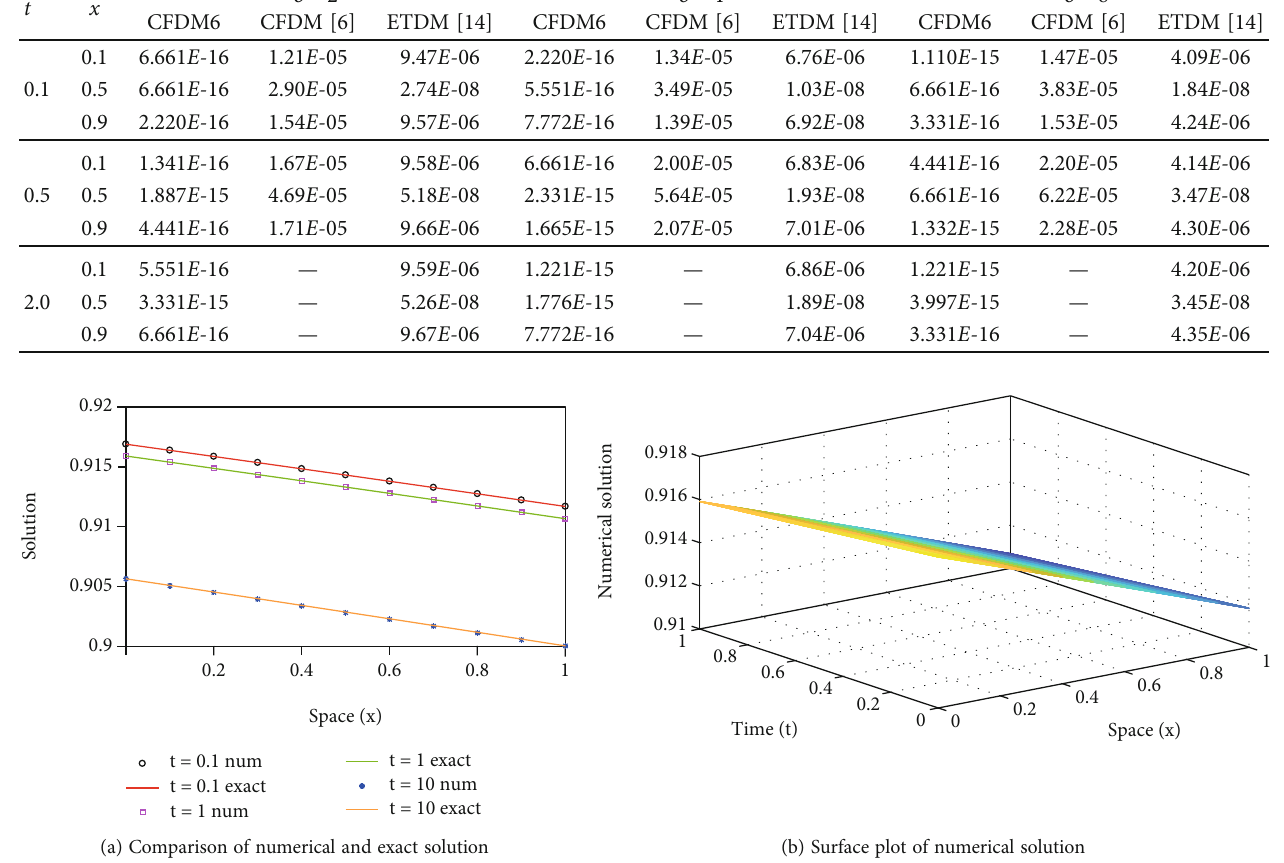
Figure 5: Graphical representation of solutions corresponding to Example 3 with N = 10 and Δ t = 0 : 001 . Table 4: Comparison of absolute error of Example 4 with β = 1 , γ = 1 , η = 0 : 001 , δ = 2 , h = 0 : 1 , and Δ t = 0 : 0001 . Method